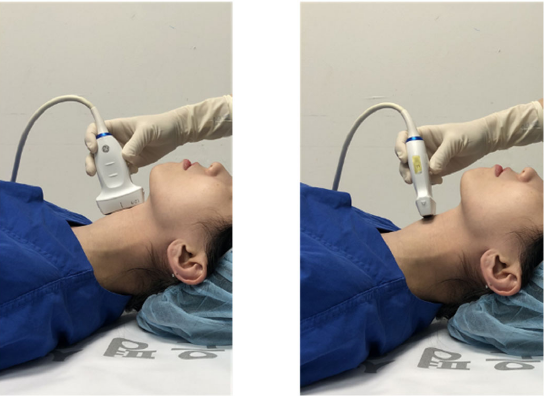
J. Clin. Med. 2022 , 11 , x FOR PEER REVIEW Figure 4. Confirmation of cricothyroid location using bedside ultrasound. Figure 4. Confirmation of cricothyroid location using bedside ultrasound. Figure 4. Confirmation of cricothyroid location using bedside ultrasound.